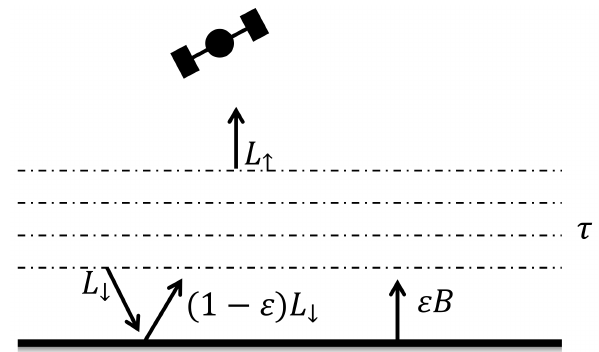
Figure 2. Schematic view of the Radiative Transfer